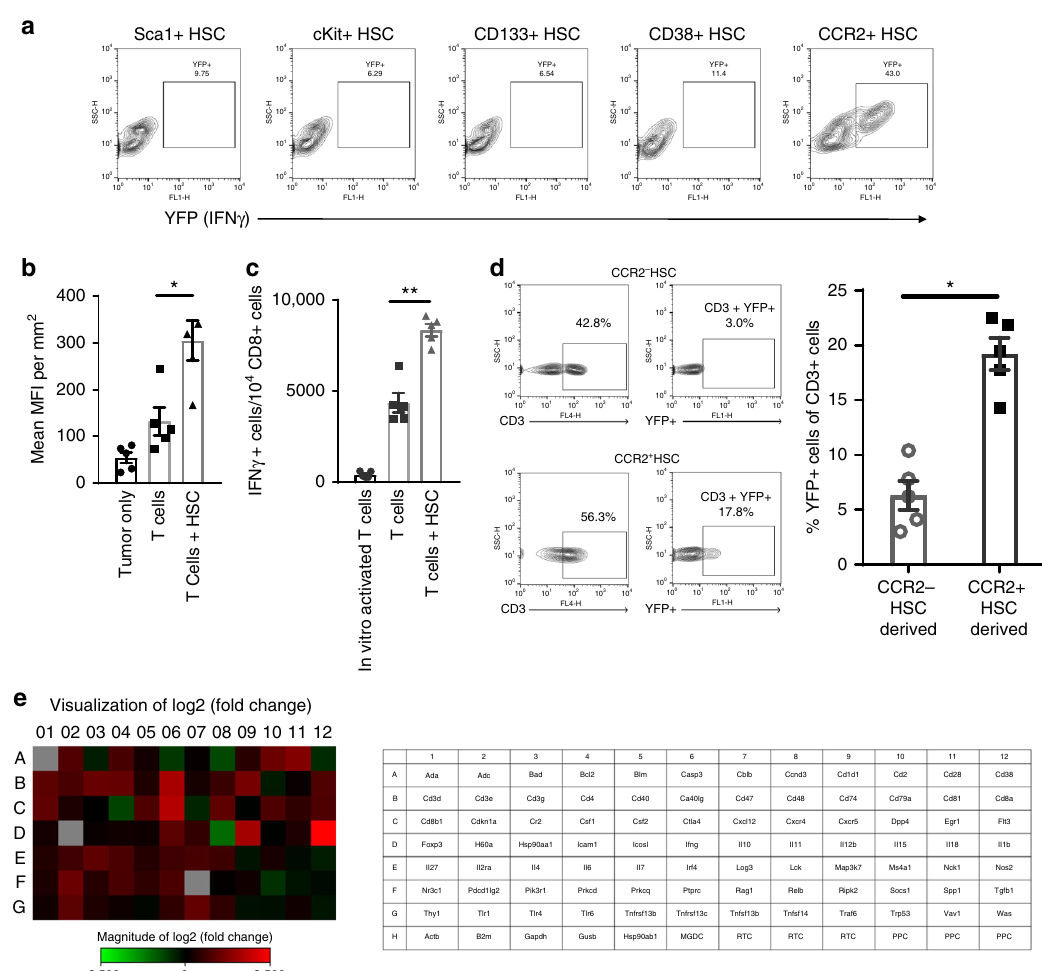
Fig. 3 CCR2 + HSCs increase T-cell activation within tumor after adoptive cell therapy. a Lineage negative HSCs were further isolated into stem and progenitor cell populations: Sca1 + HSCs, cKit + HSCs, CD133 + HSCs, CD38 + HSCs, CCR2 + HSCs. Each progenitor cell population was transferred with tumor-reactive T-cells (generated from GREAT mice) into tumor-bearing mice. Relative amounts of YFP + was measured in the tumors. b Late-stage